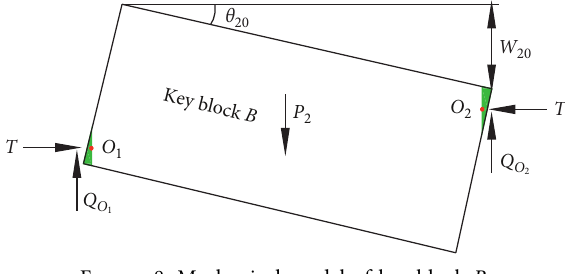
Figure 8: Mechanical model of key block B